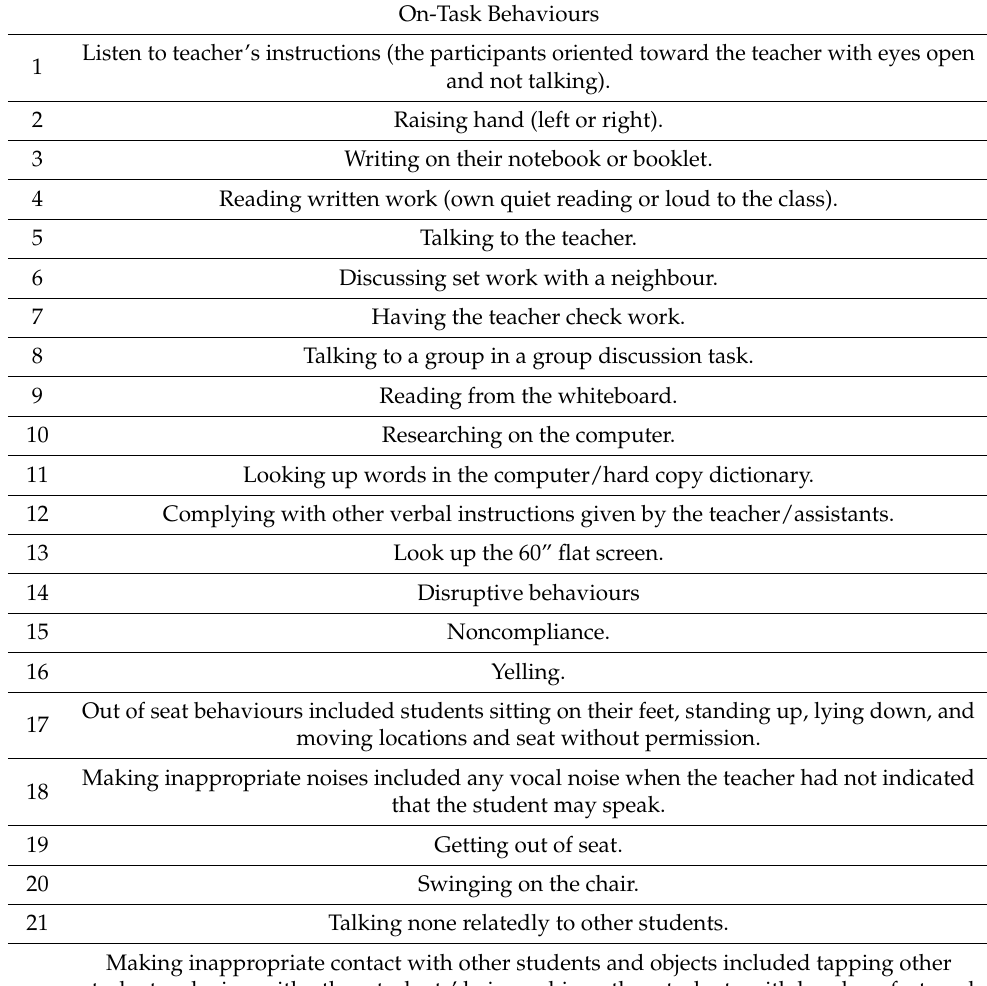
Table 1. On-task and disruptive classroom behaviours.